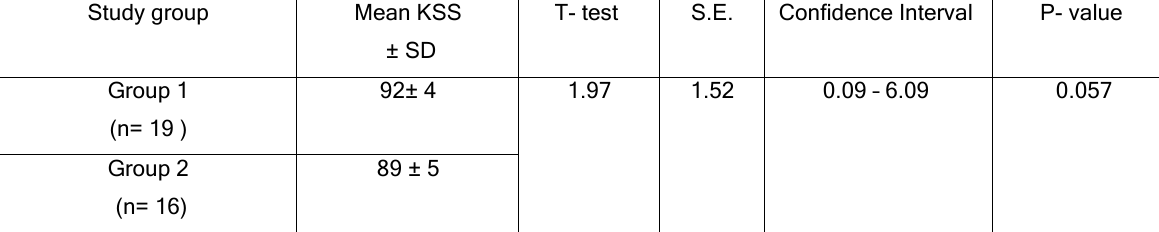
Table (7): A comparison between study groups in current study regarding KSS after 1 year of